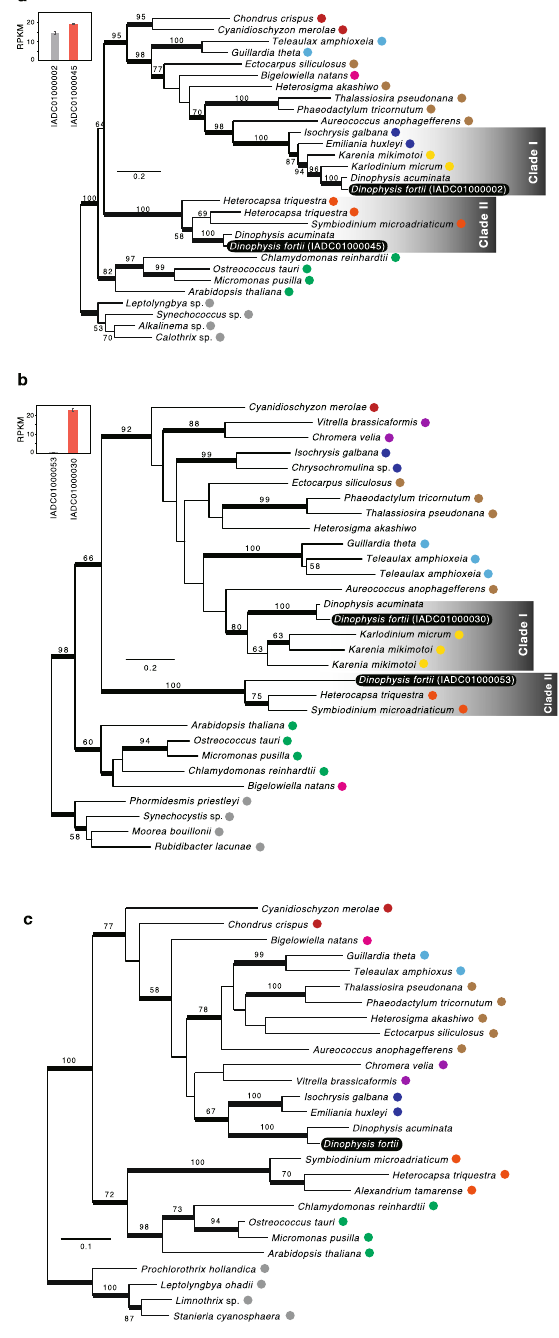
Figure 2. Maximum-likelihood trees of ( a ) IspH, ( b ) phytoene synthase and ( c ) ChlP. Bootstrap values ≥ 50% are shown. Nodes supported by Bayesian posterior probabilities ≥ 0.95 are highlighted with bold lines. Where two or more isoforms were identified, transcription levels are shown in the inset bar chart in the top left corner, and the isoform with the highest transcription level is highlighted with a red bar in the bar chart. Transcriptome shotgun assembly (TSA) accession numbers are shown in parentheses. Coloured circles indicate proteins from the same organisms as described in Fig.